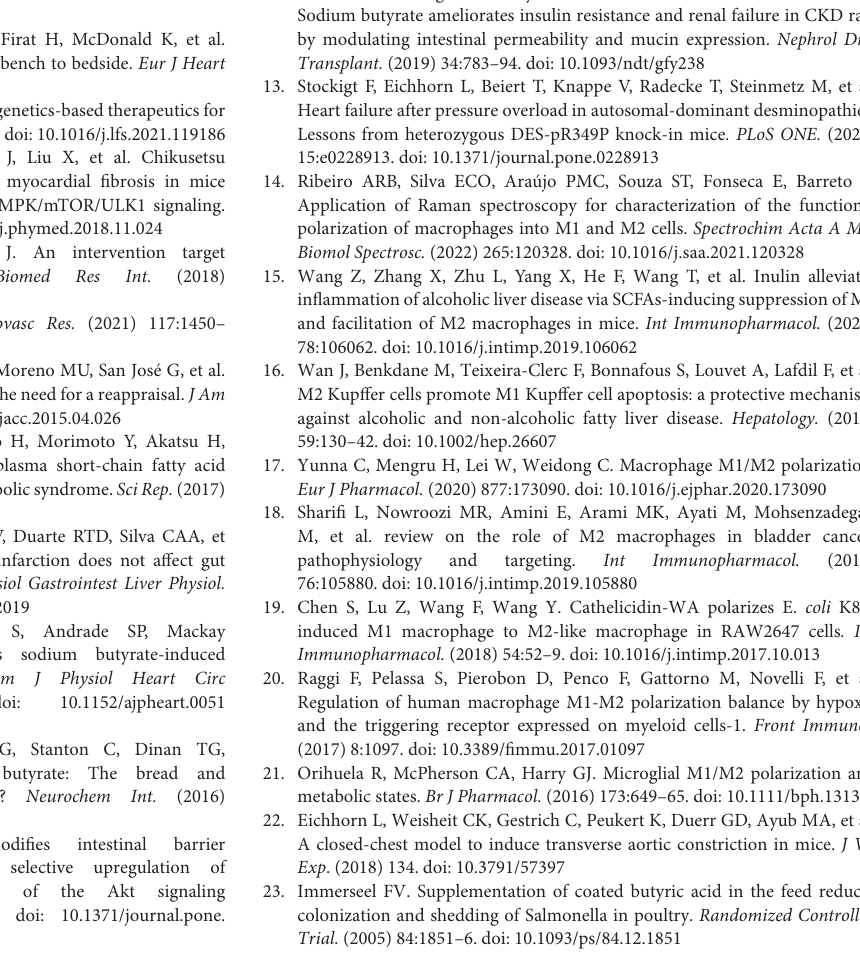
Supplementary Figure 1 | Flow cytometry results about influences of butyrate on M1/M2 polarization of rat macrophages RMa-bm. (A) Flow cytometry results about CD86 (+), CD80 (+), CD64 (+), and CD16/32 (+) positive cell rates in the Control, LPS, and LPS+butyrate groups, respectively. (B) Flow cytometry results about CD163 (+) and CD206 (+) positive cell rates in the Control, IL-4, and IL-4+butyrate